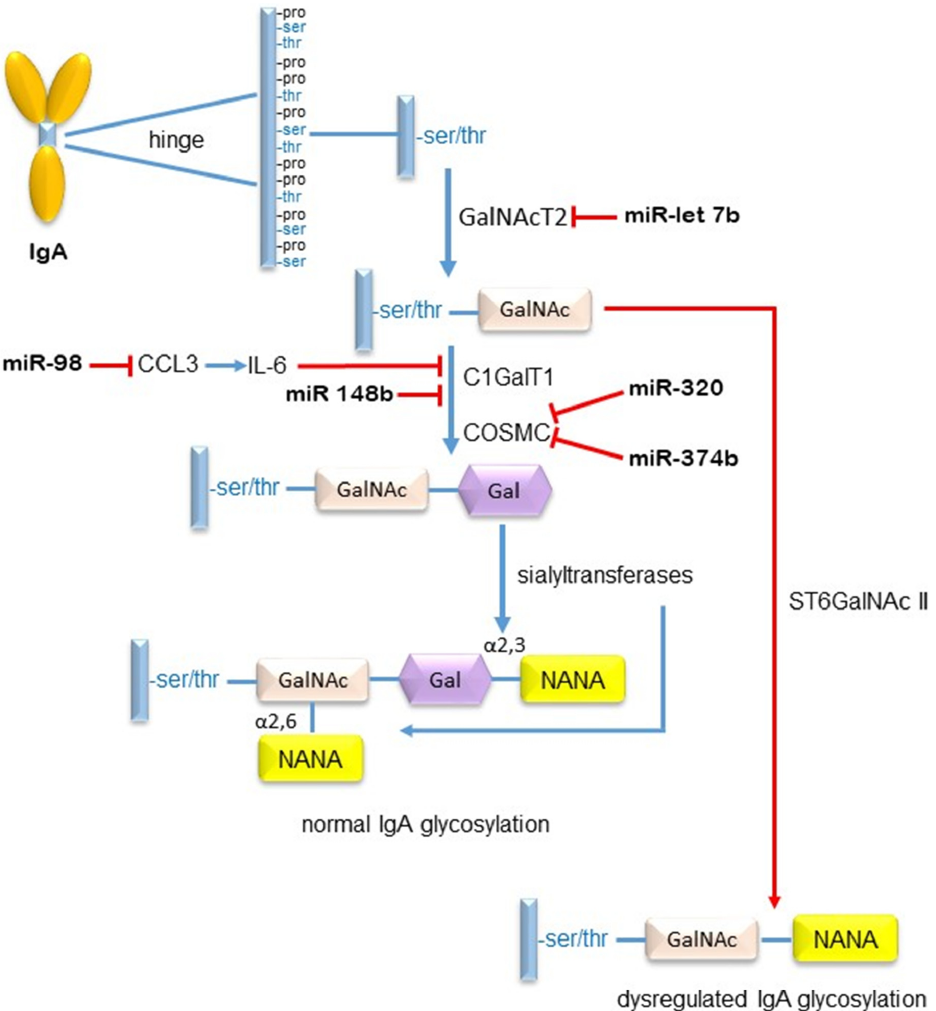
Figure 4. MicroRNAs which modulate IgA1 O -glycosylation. The process of IgA hinge region O -glycosylation is initiated by attachment of N-acetyl galactosamine (GalNAc) to a serine or threo- nine amino acid by the actions of N-acetyl-galactosamine transferase 2 (GalNAc T2). Galactose is sequentially attached by core 1 β ,3-galactosyltransferase (C1GalT1) with the aid of its chaperone protein COSMC. N-acetyl neuraminic acid (NANA) can then be added to galactose by the actions of β -galactoside α -2,3 sialyl transferase 1 (ST3Gal1) for linkage in the α 2-3 orientation or to N- acetylgalactosamine by α -N-acetylgalactosaminide sialyl transferase 2 (ST6 GalNAc 2) for linkage in the α 2-6 orientation. However, miR-let-7b can prevent the addition of GalNAc to its hydroxylated amino acid. MiR-148 and miR-98 can reduce the activity of C1GalT1, thereby reducing the binding of galactose to GalNAc. MiRs -320 and -374 can downregulate COSMC, reducing the ability of C1GalT1 to galactosylate N-acetyl galactosamine. Consequently, ST6GalNAc 2 can add NANA to the naked GalNAc sugar residue, preventing further extension of the sugar chain resulting in less O -galactosylation of